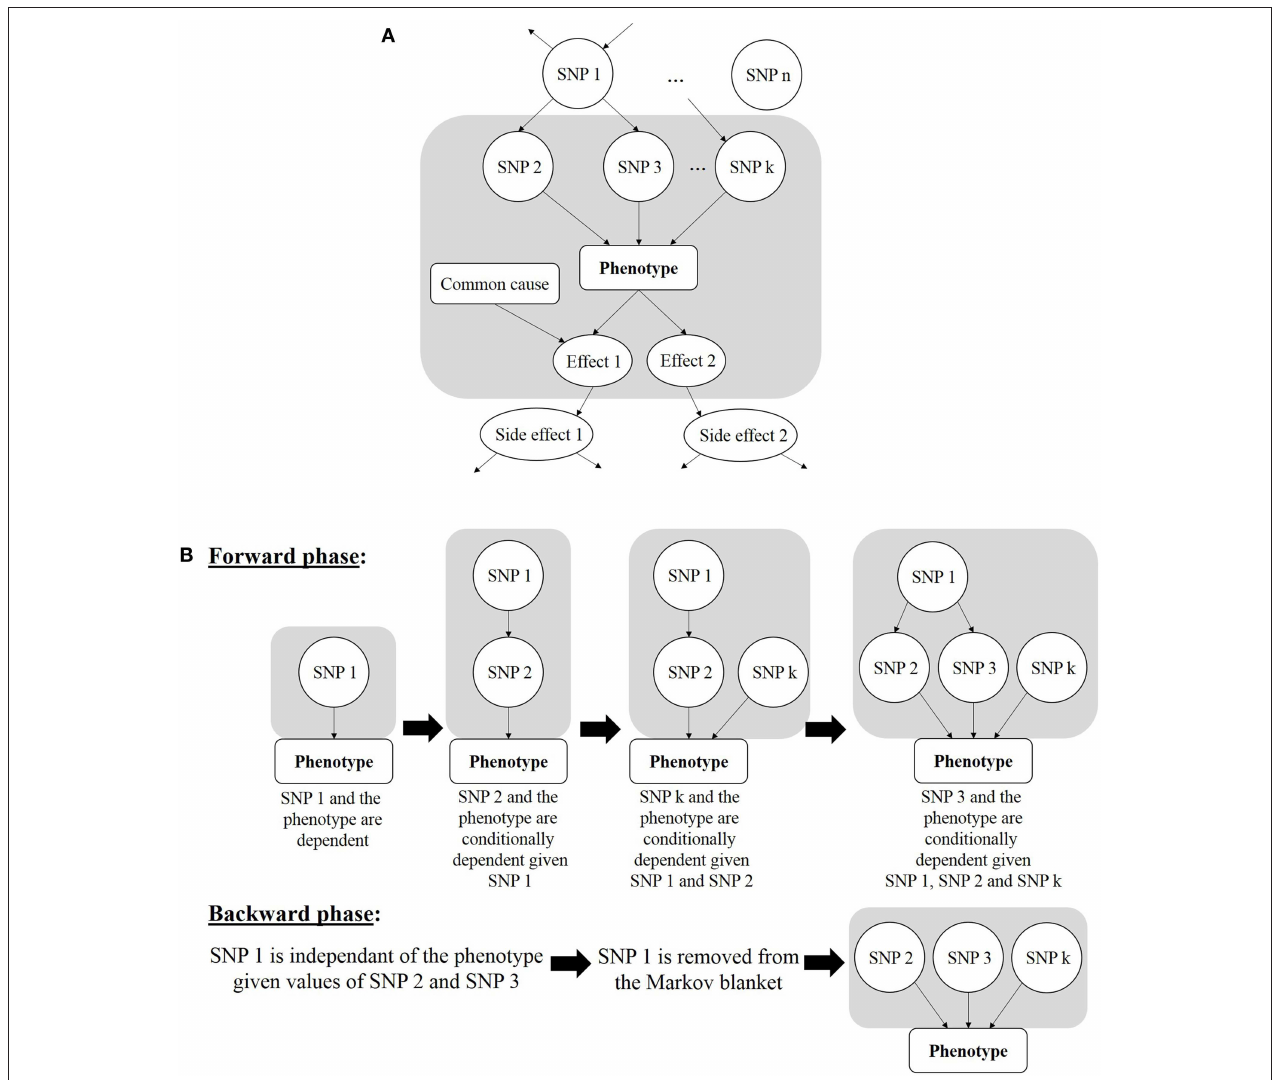
FIGURE 7 | (A) Markov blanket of a phenotype, in gray area. It is made of the parents (SNP 2, SNP 3, and SNP k), of the children (Effect 1 and Effect 2) and of the spouses (Common cause of Effect 1 with respect to the Phenotype). (B) Two stages of Markov blanket learning. For ease of reading, the Markov blanket is reduced to parents from (A)